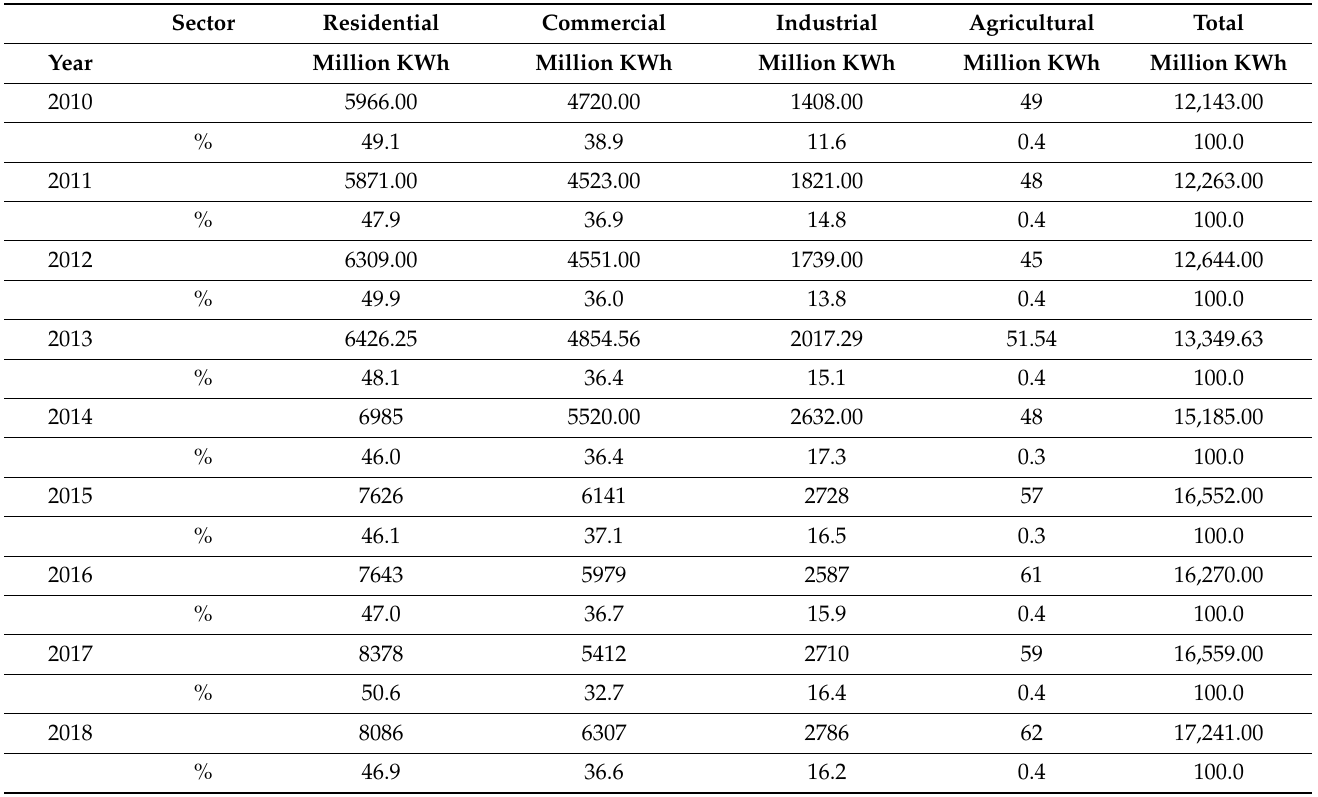
Table 5. Annual electricity usage by all sectors in Bahrain, 2010–2018 [4].